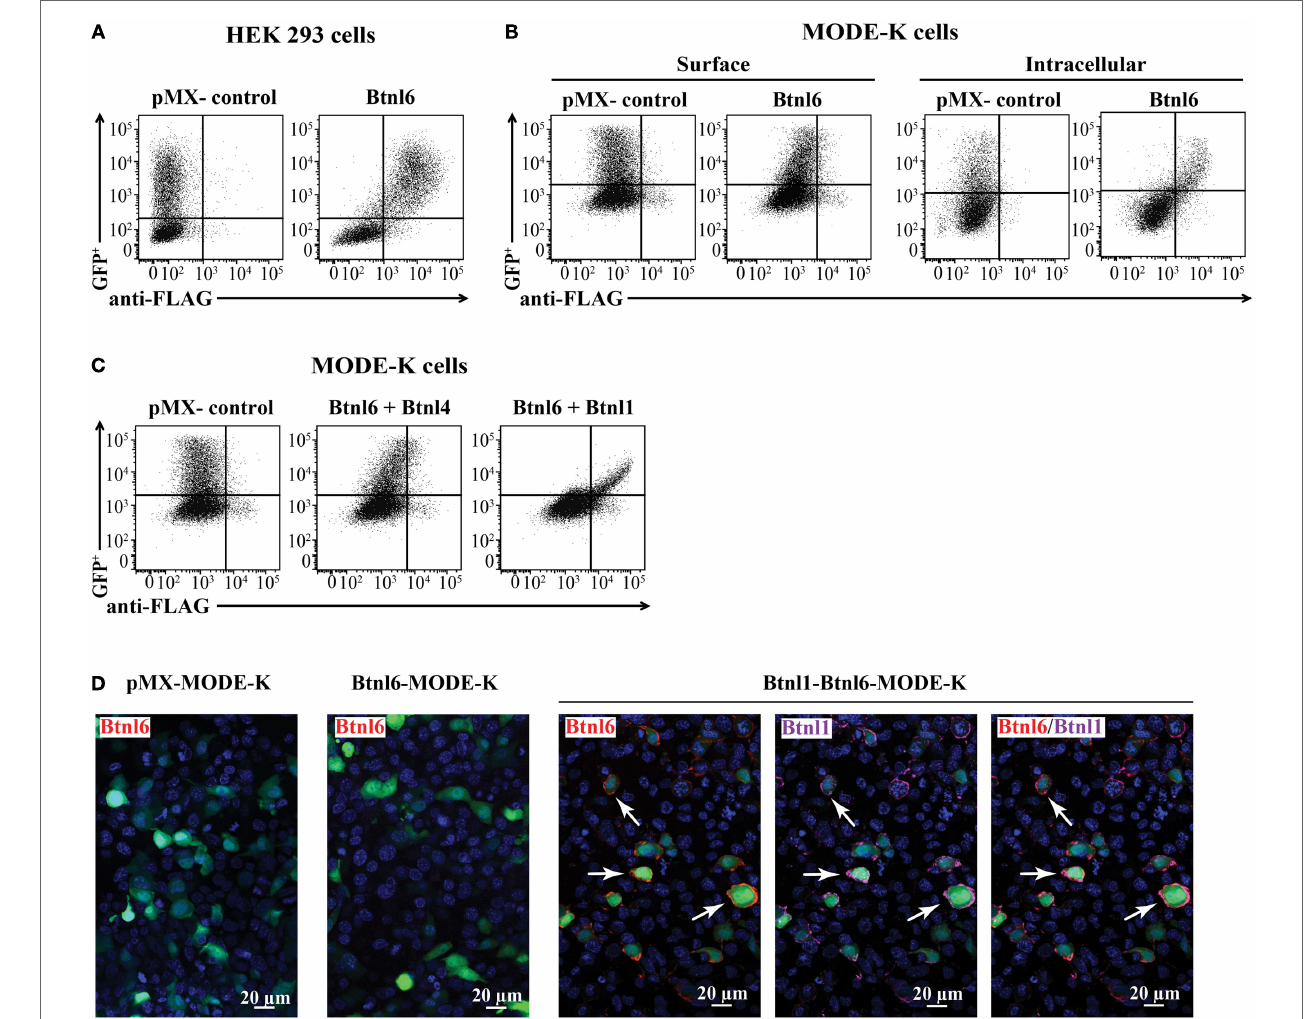
FigUre 2 | Btnl6 expression. (a) HEK 293 cells were transfected with N-terminal FLAG-tagged Btnl6 cDNA pMX-IRES-GFP. An anti-FLAG antibody detected cell surface expression of Btnl6 but not gfp + HEK 293 cells transfected with empty vector (pMX-IRES-GFP). (B) Murine small intestinal epithelial cells, MODE-K cells, were transfected with N-terminal FLAG-tagged Btnl6 cDNA pMX-IRES-GFP. Cells were stained with an anti-FLAG antibody for cell surface expression of Btnl6, or permeabilized for detection of intracellular Btnl6 localization. Btnl6 could not be detected on the plasma membrane of transfected MODE-K cells. Instead, Btnl6 was retained in the intracellular compartment as evident by anti-FLAG staining. (c) MODE-K cells were cotransfected with untagged Btnl4 cDNA- and N-terminal FLAG-tagged Btnl6 cDNA pMX-IRES-GFP, or untagged Btnl1 cDNA- and N-terminal FLAG-tagged Btnl6 cDNA pMX-IRES-GFP. An anti-FLAG antibody detected cell surface expression of Btnl6 on the Btnl1–Btnl6 cotransfectants, but not on the Btnl4–Btnl6 cotransfectants. Representative plots (a–c) from single experiments out of three independent experiments are shown. (D) MODE-K cells were transfected with N-terminal FLAG-tagged Btnl6 cDNA pMX-IRES-GFP, FLAG-tagged Btnl6 cDNA- and HA-tagged Btnl1 cDNA pMX-IRES-GFP, or empty vector (pMX-IRES-GFP). While no Btnl6 expression was detected on the cell surface of MODE-K cells transfected with Btnl6, Btnl6 was detected on most Btnl1–Btnl6 cotransfectants. Btnl6-, Btnl1-, and double-stained Btnl1 + Btnl6 expressing cells are exemplified by arrows. Anti-FLAG antibody was used for detection of FLAG-Btnl6 (red) and anti-HA antibody was used for detection of HA-Btnl1 (purple). Slides were counterstained with DAPI (blue) to visualize nuclei. The green staining indicates transfected, GFP + cells. Original magnification 20 × . Images are representative of three